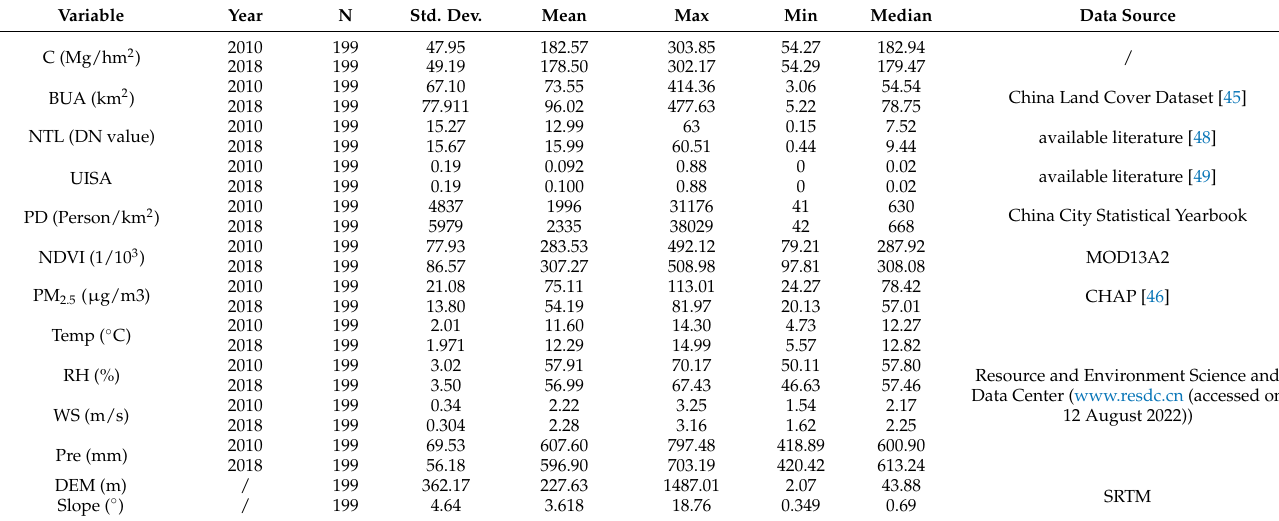
Table 1. Descriptive statistics for variables used in this